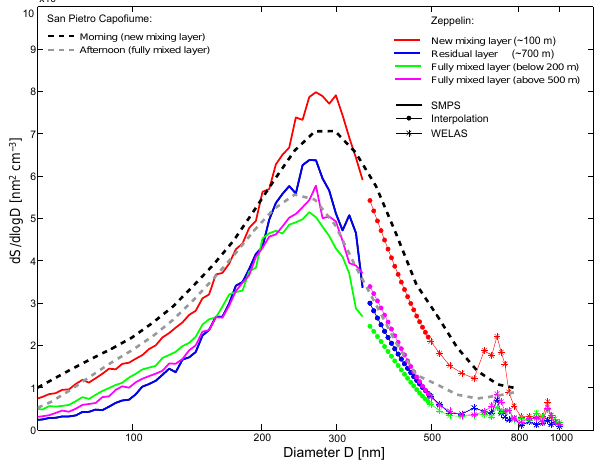
Figure 3. Dry surface area size distributions for different times and layers were probed during 20 June 2012. The coloured lines denote the results measured on board the Zeppelin showing the contribu- tion by the SMPS (straight line), WELAS (stars) and the interpo- lation in between (dotted line). During the early morning hours the new mixing layer (red line) and just above the residual layer (blue line) could be probed. Later during the day the results are represen- tative for the fully mixed layer (green and pink lines for different altitudes). The dashed lines were recorded at the SPC ground sta- tions, where the black line shows the results for the morning hours (new mixing layer) and the gray line for the early afternoon (fully developed mixed layer).